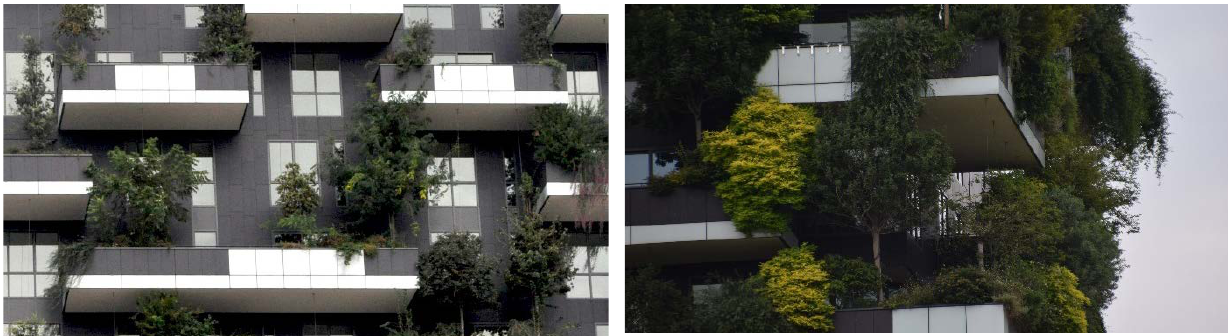
Figure 7. Vegetation on the Bosco Verticale; ( left ): in 2014 (Phil Beard 2014); ( right ): in 2019 (George Groutas 2019).